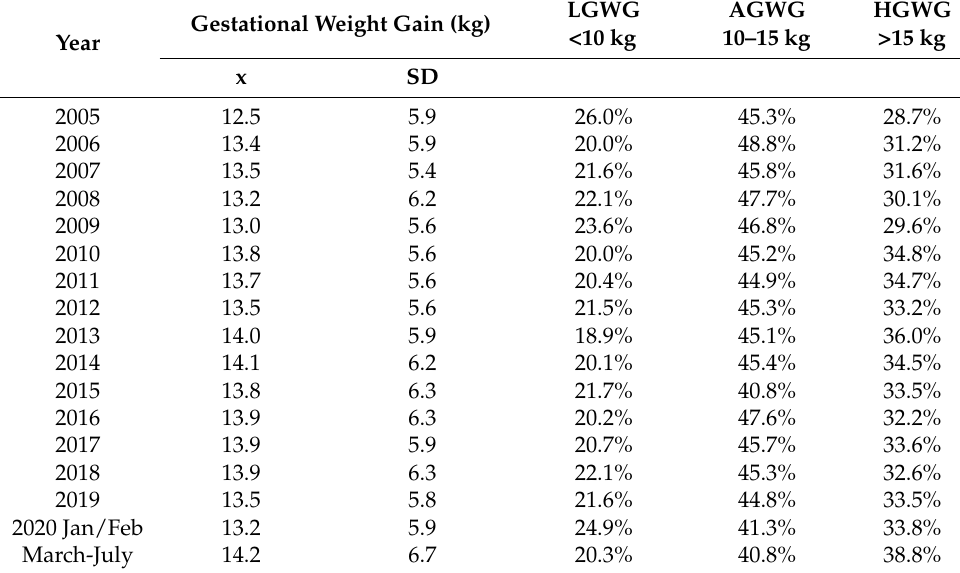
Table 5. Maternal gestational weight gain categories LGWG (<10 kg), AGWG (10–15 kg), HGWG (>15 kg) at the Danube Hospital between 2005 and